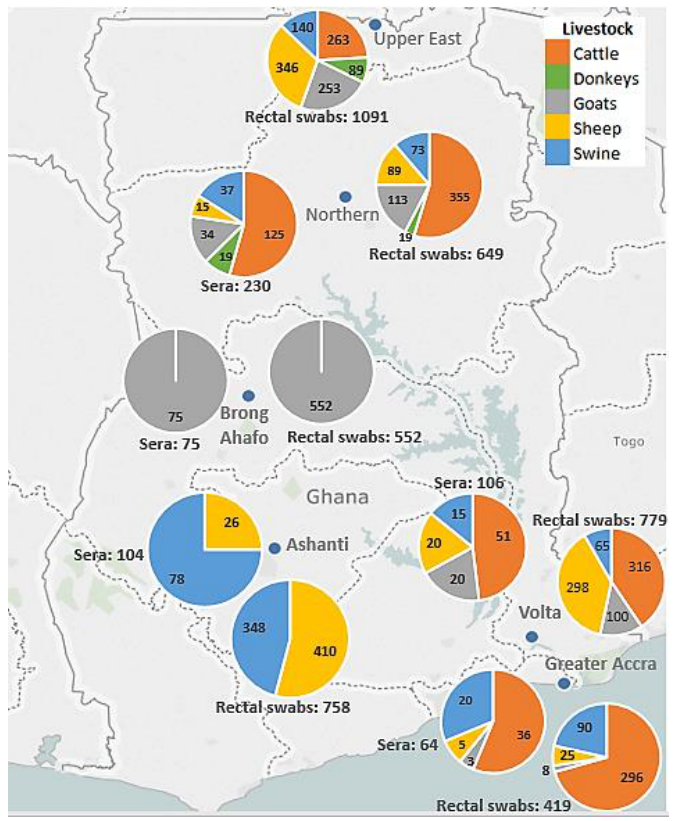
Figure 1. Map of Ghana showing distribution of livestock samples collected across the